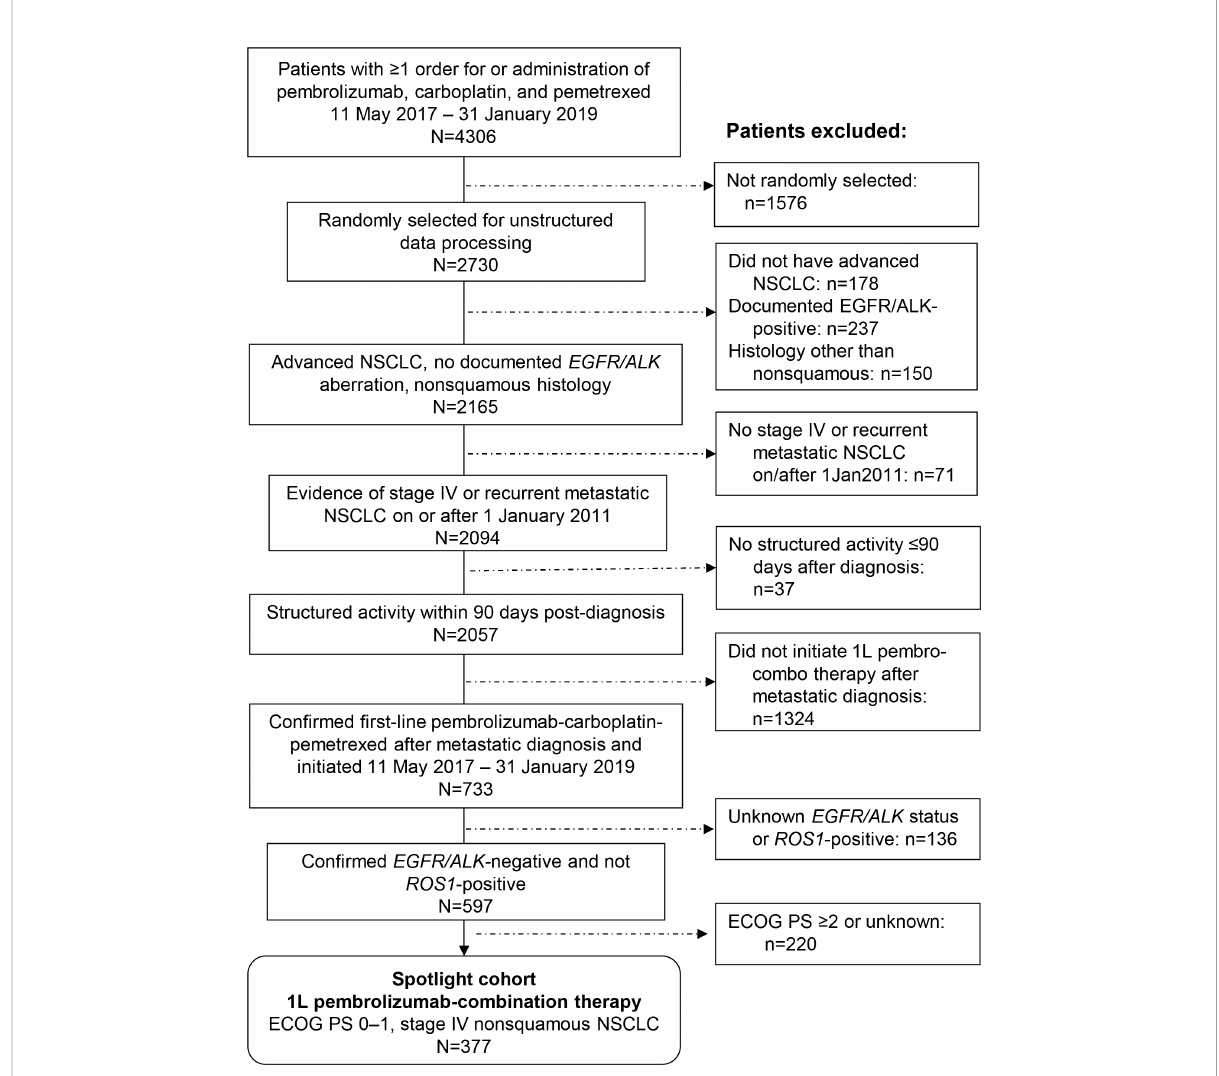
FIGURE 1 Patient selection from the Flatiron Health Database. 1L, fi rst-line; ECOG PS, Eastern Cooperative Oncology Group performance